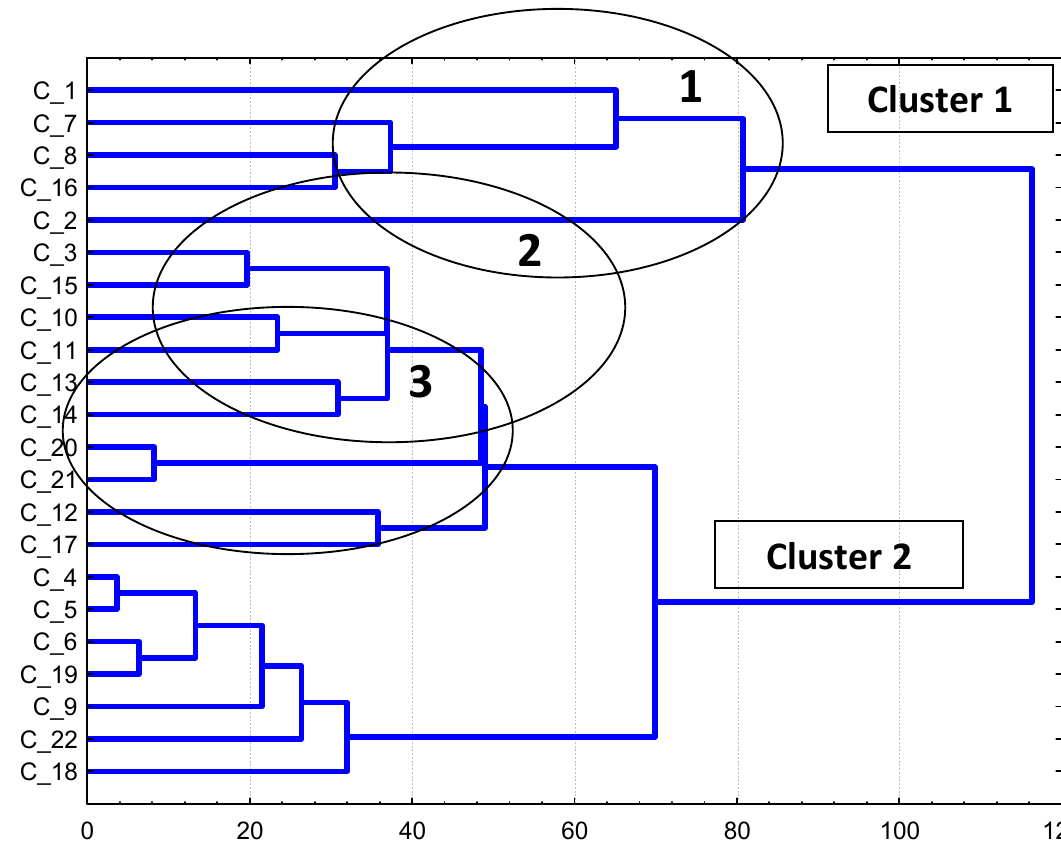
Fig.1 Not weighted pair mean Euclidean distances for variants of teenagers’ motion